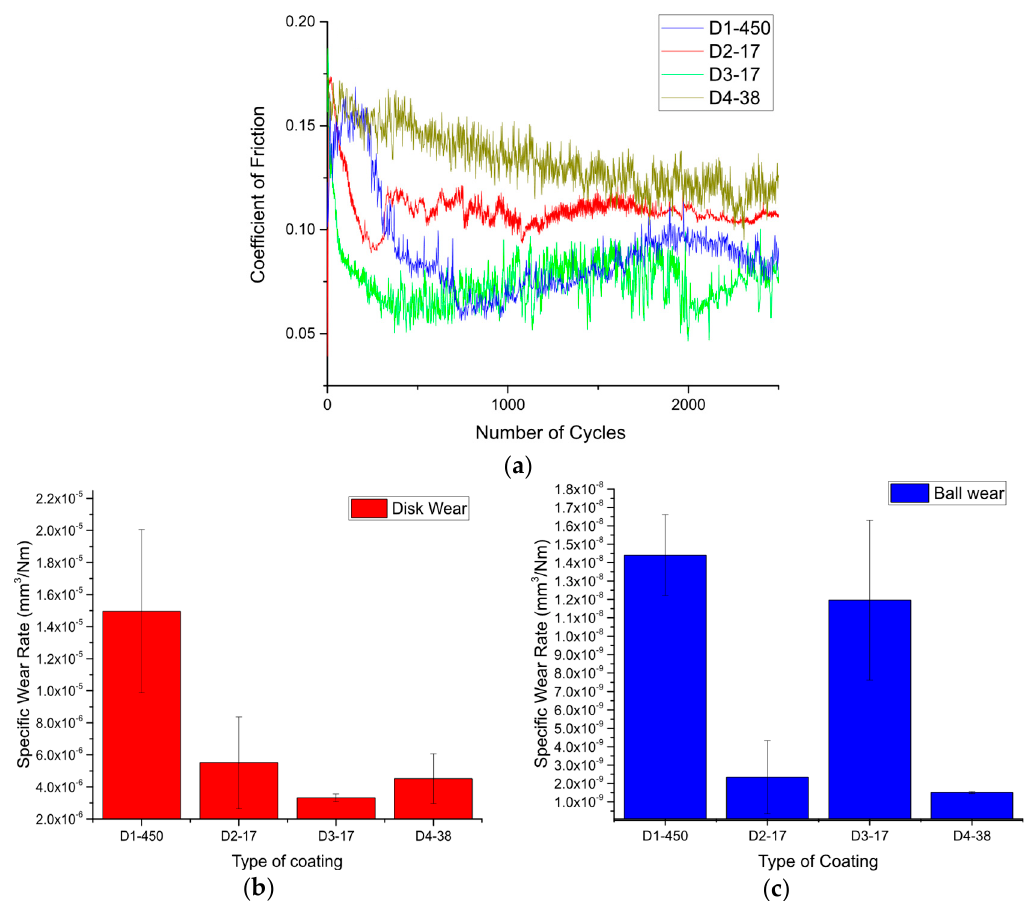
Figure 10. Tribological properties of selected coatings: ( a ) friction coefficient; ( b ) specific wear rate of the coated disks; ( c ) specific wear rate of the balls.